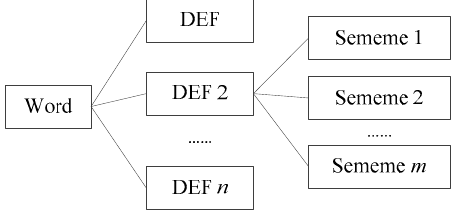
Figure 2. Word description of HowNet.